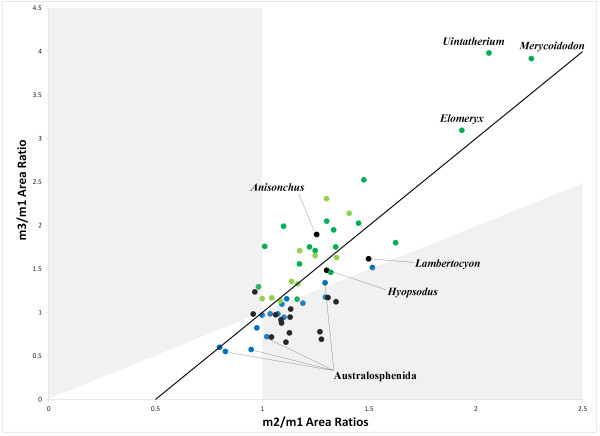
Morphospace positions for Mesozoic mammals and the extant and “archaic” ungulates. Mesozoic mammals (coloured in blue) are found near the centre (1,1) of the morphospace, closer to the plesiomorphic conditions of equal-sized molars. “Condylarths”, coloured black, are found mostly in the region of the morphospace where m2 is the largest molar, and are separate from Artiodactyla (dark green) and Perissodactyla (light green), with the exceptions of Hyopsodus, Anisonchus and Lambertocyon, all of which possess molars that increase in size posteriorly. Artiodactyla show the most extreme increase in molar size, with Uintacyon, Elomeryx and Merycoidodon exhibiting six-fold or more increases in molar area from m1 to m3.